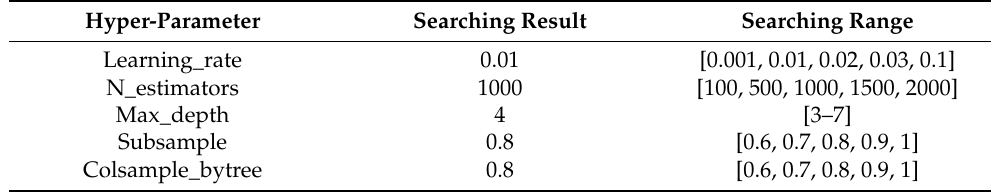
Table 2. Grid search results of the base classifier XGBoost.